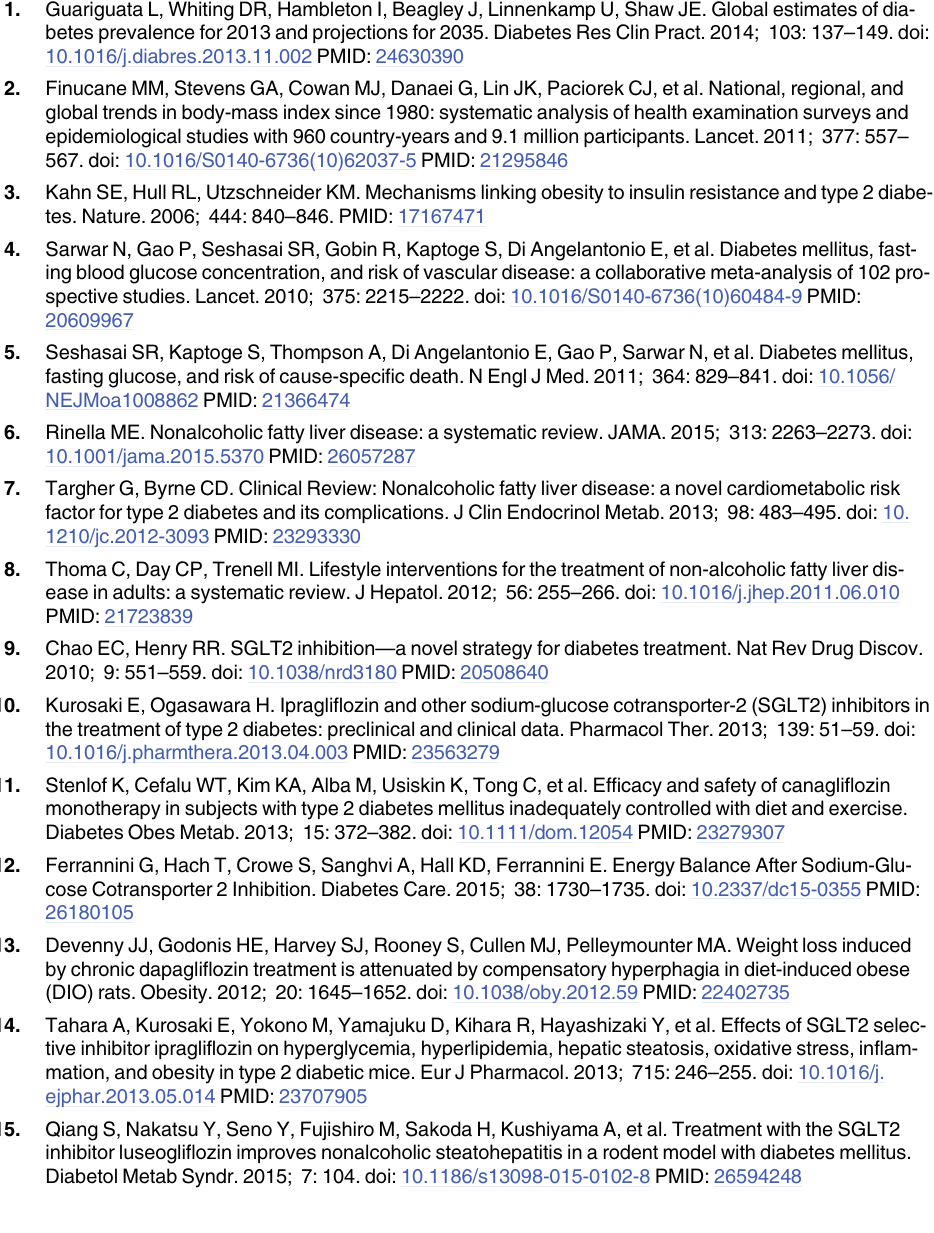
S1 Table. List of primers. S2 Table. Baseline characteristics of T2DM patients with hepatic